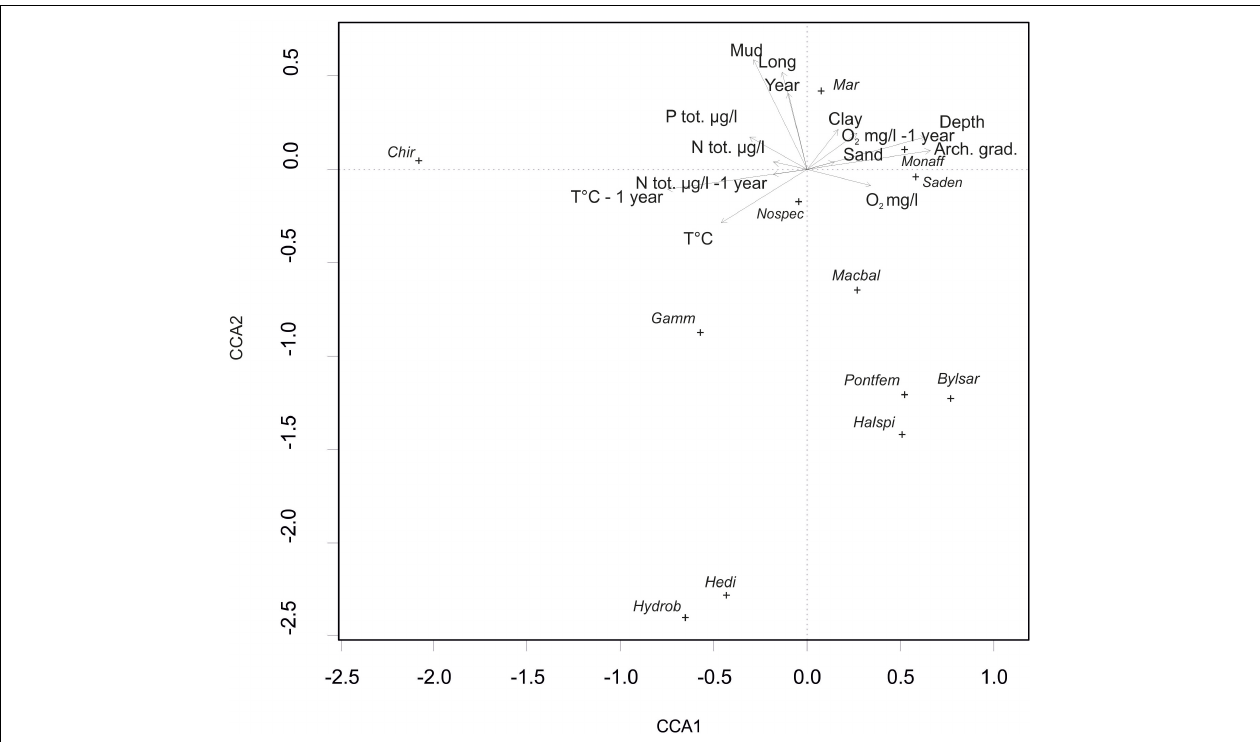
FIGURE 4 | A CCA biplot depicting the effect of the statistically significant environmental variables (see Table 1 ), on the distribution and abundance of zoobenthic species (Mar – Marenzelleria spp., Bylsar – Bylgides sarsi , Halspi – Halicryptus spinulosus , Hedi – Hediste diversicolor , Gamm – Gammarus spp., Monaff – Monoporeia affinis , Pontfem – Pontoporeia femorata , Saden – Saduria entomon , Macbal – Limecola ( Macoma ) balthica , Hydrob – Hydrobia spp. Chir –